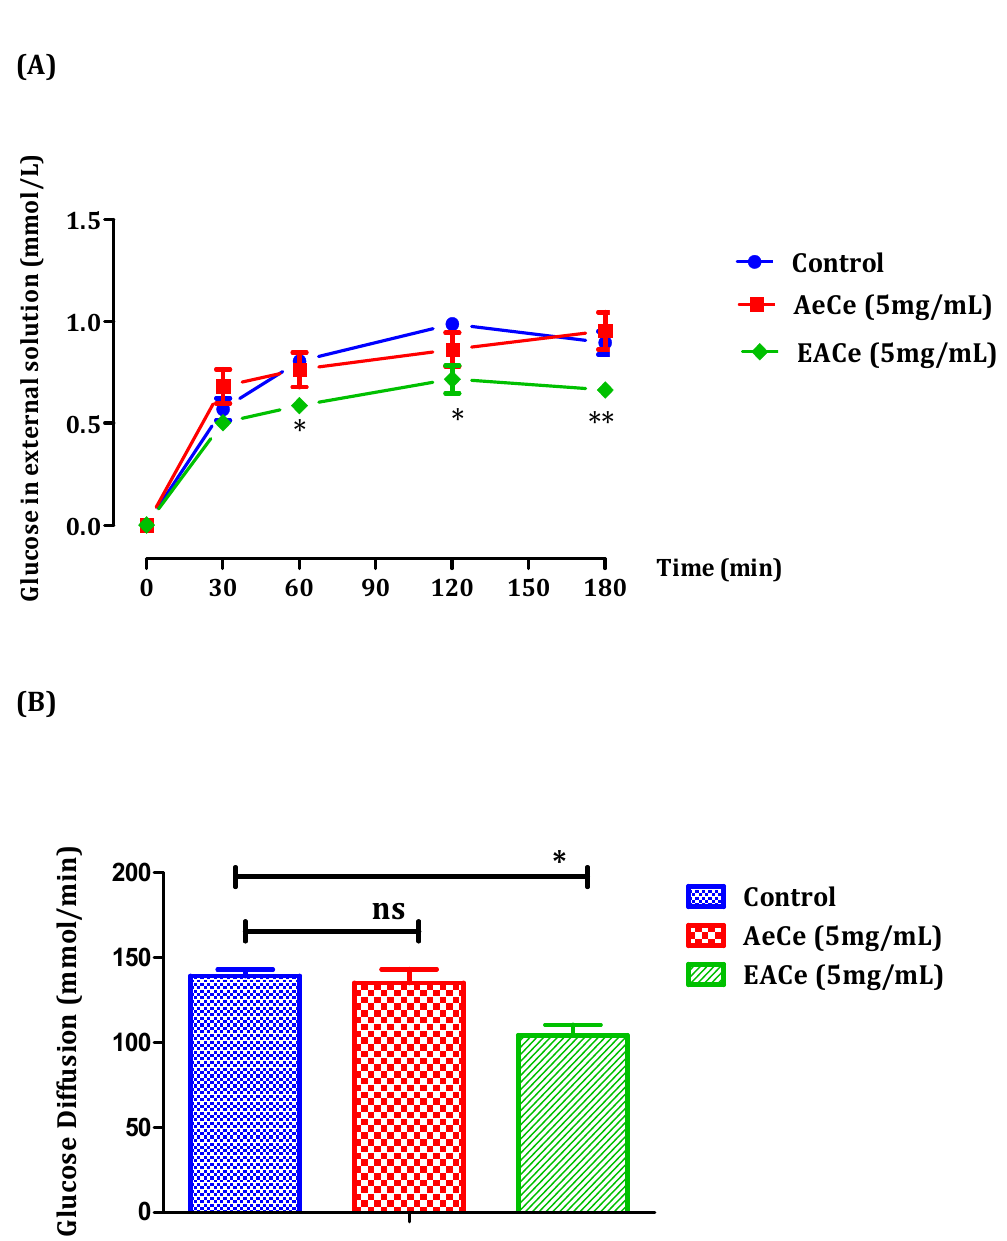
Figure 4. Effect of aqueous extract and fractions of C. europaea (5 mg/mL) on glucose diffusion through a dialysis membrane ( A ), and with a representation of the area under the curve of tested extracts ( B ). The values are the means ± SEM ( n = 6). * p < 0.05, ** p < 0.01 compared to the control